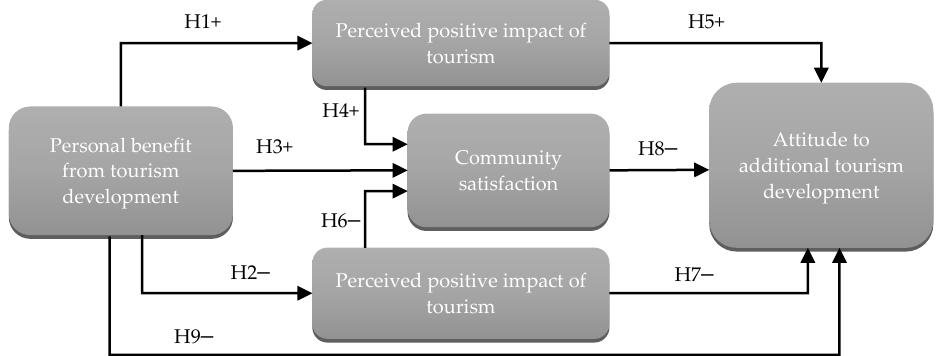
Figure 2. The relation between tourism development and community’s attitude . Source: Stewart and Ko (2002). A structural equation model of residents’ attitudes for tourism development. Tourism Management, no. 23.